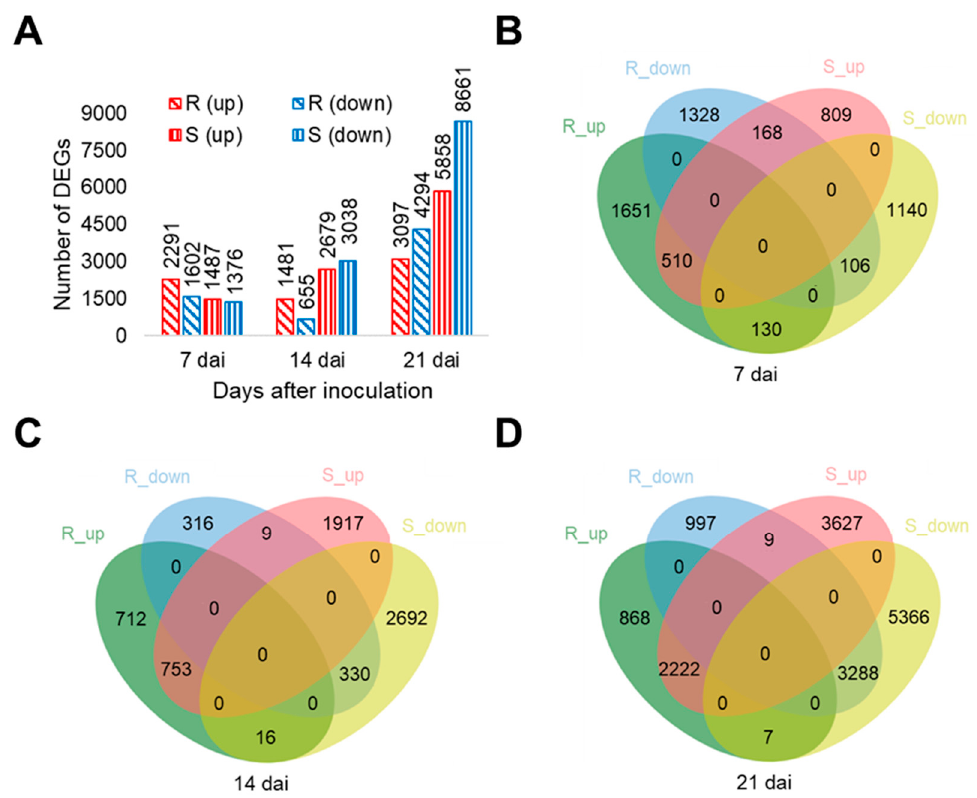
Figure 2. Number of differentially expressed transcripts in each rutabaga cultivar and time-point. ( A ) Number of total differentially expressed transcripts in each cultivar and time-point. ( B-D ) Venn cultivars at 7 ( B ), 14 ( C ) and 21 ( D ) days after inoculation (dai). Up, upregulation; down,